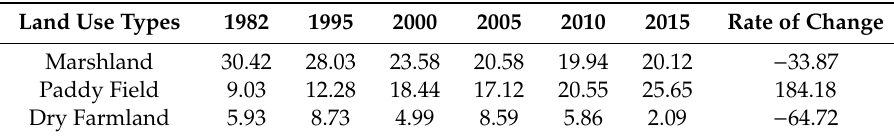
Table 2. Percentages of land use types from 1982 to 2015